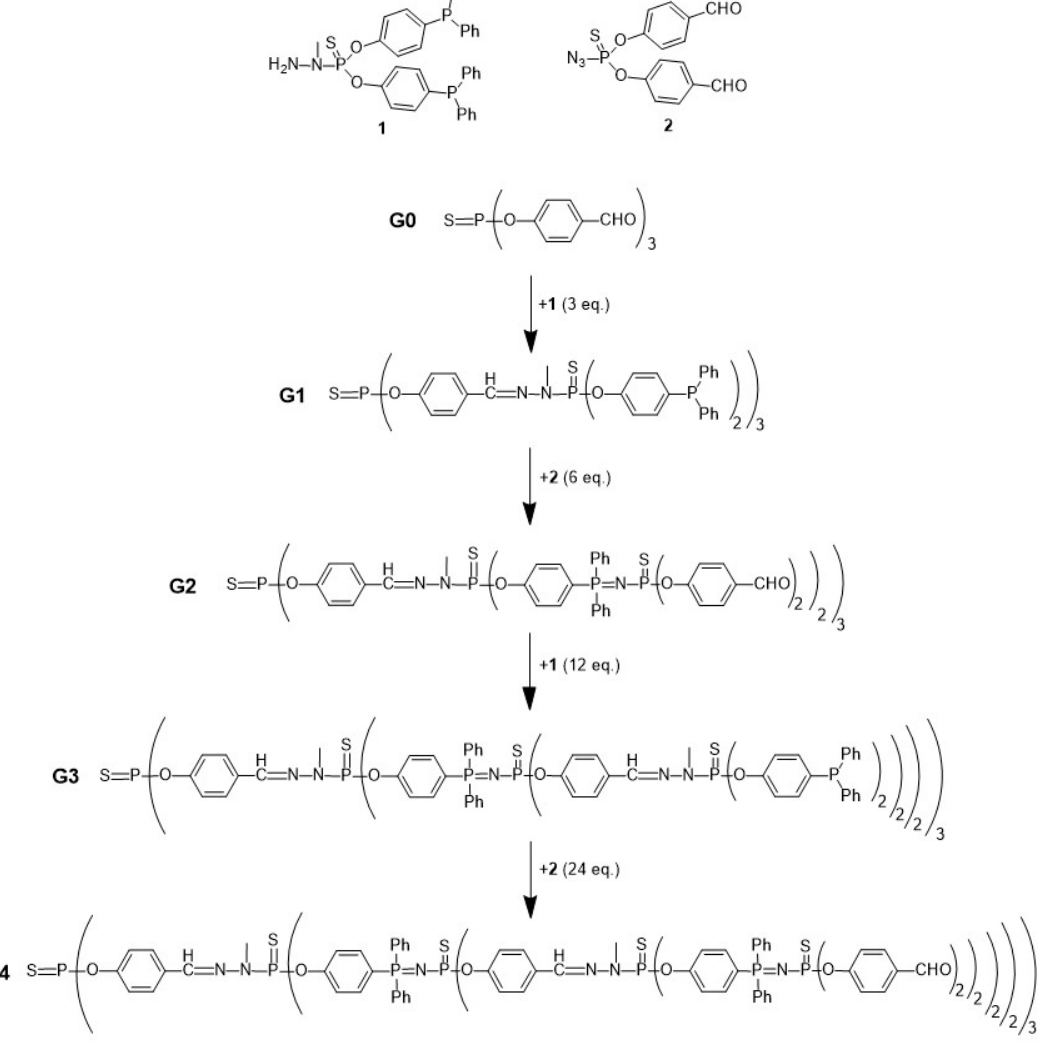
Figure 6. Synthesis of G4 phosphorous-containing dendrimers via the orthogonal coupling method. Synthetic route described in Brauge et al. [265].